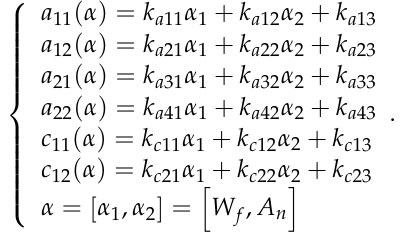
(cid:16) α = [ W f , A n ]